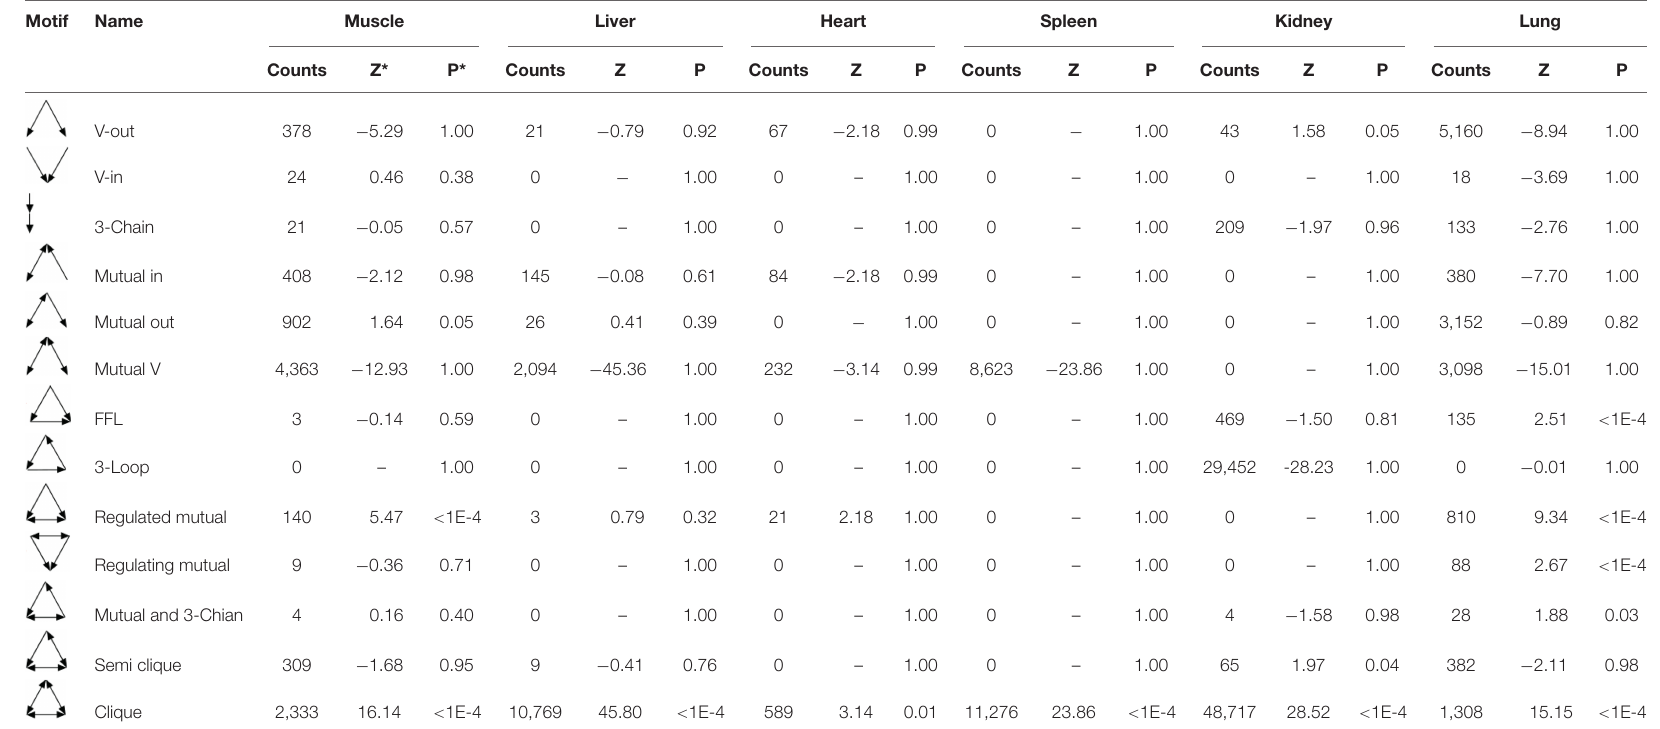
TABLE 5 | Motif information in regulatory networks of six tissues in Tibetan